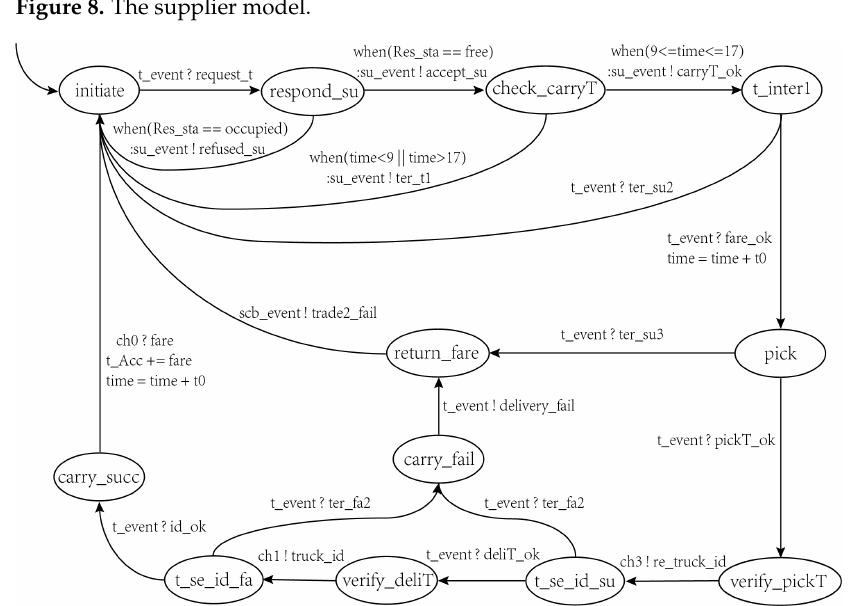
Figure 8. The supplier model.